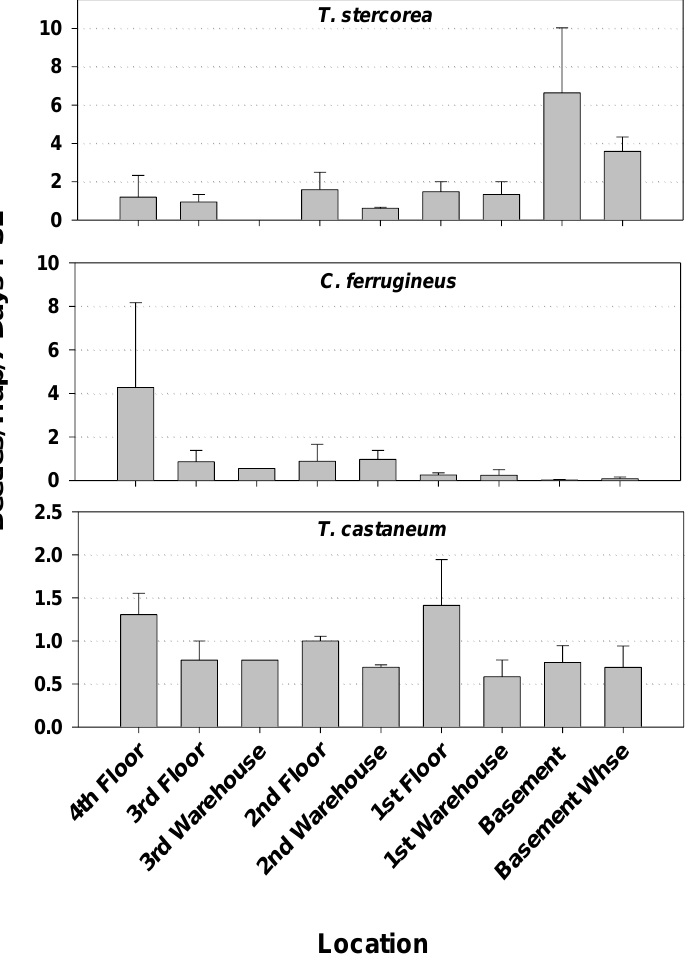
Figure 4. Capture of the three most commonly trapped beetle pests by location within mill 2 during Year 2. Results are from 18 weekly observations from 17 modified pitfall traps. Capture of T. stercorea was not significantly different by location ( F = 2.28; df = 8, 8; p = 0.1326). There was not a significant difference in capture of C. ferrugineus ( F = 0.84; df = 8, 8; p = 0.5917). Capture of T. castaneum was not significantly different by location ( F = 1.25; df = 8, 8; p = 0.3804).